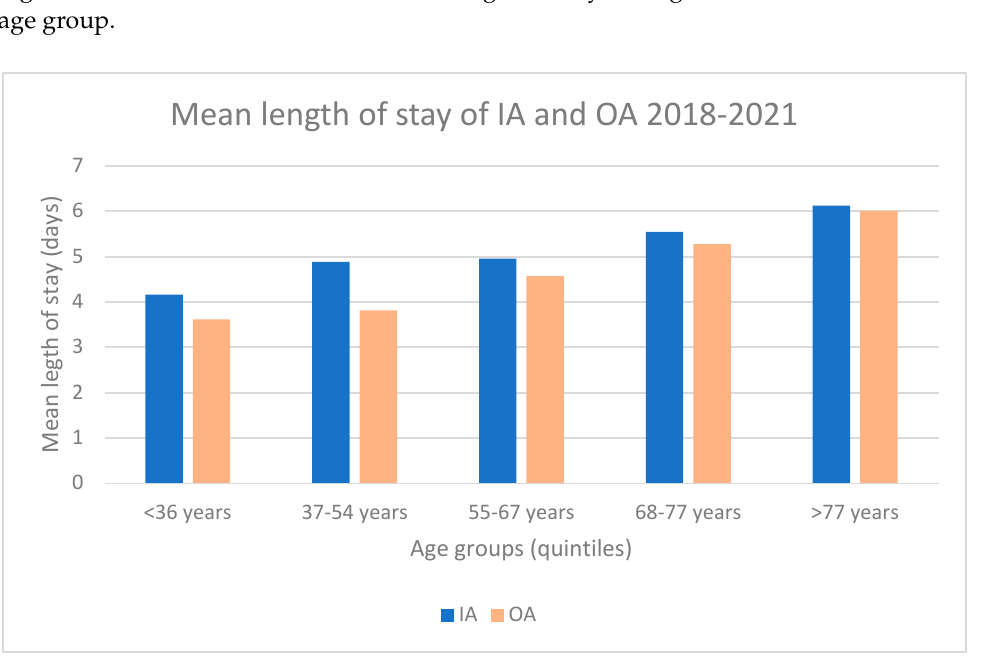
Figure 2. Comparison of the mean length of stay of IA and OA (2018–2021).